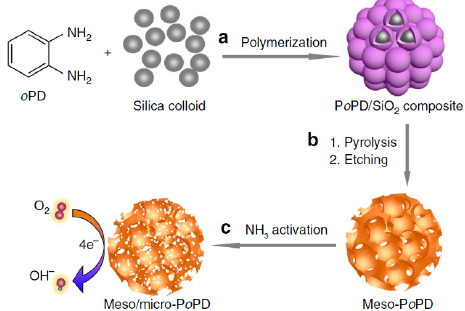
Schematic illustration of the fabrication of meso/micro-PoPD electrocatalyst.